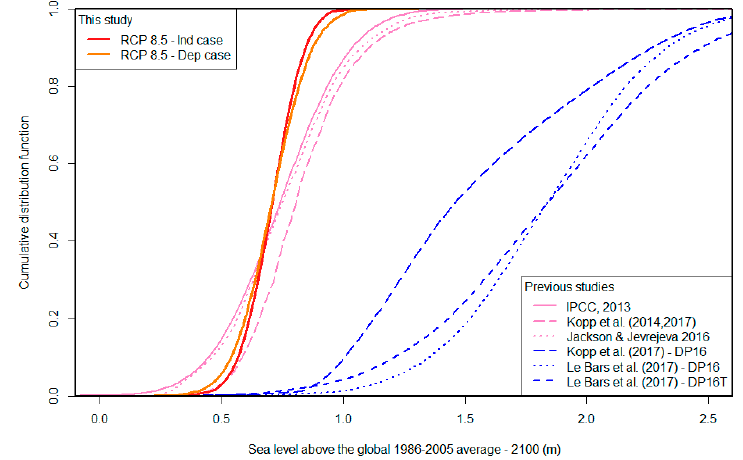
Figure 5. Comparison of global probabilistic projections with previous studies [1,19,29,35,45,46], RCP8.5, 2100 (unit: m); DP16 refers to De Conto and Pollard (2016) [33].